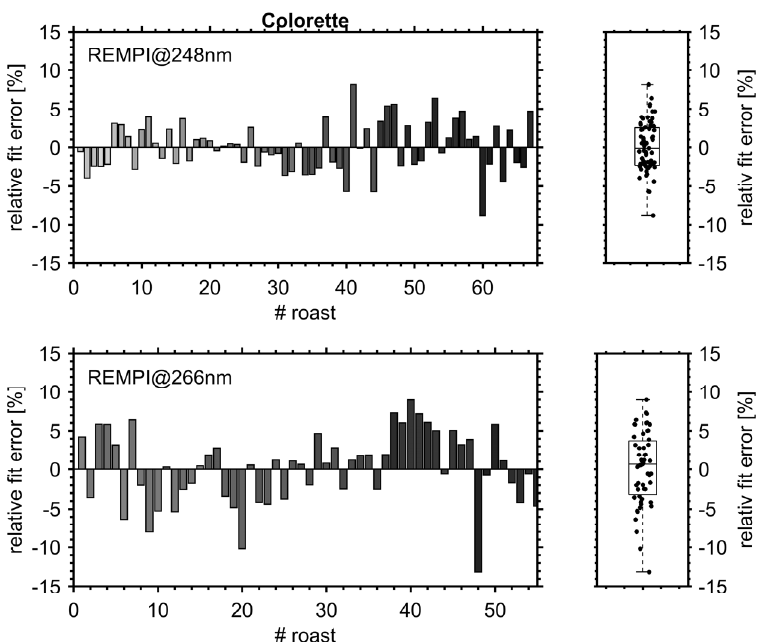
Figure A3. Relative fit error of individual roasts included in the calibration of the Colorette prediction models ( left ) and its summary in a boxplot ( right ) showing minimum, maximum, 1st, 2nd (median) and 3rd quartiles.